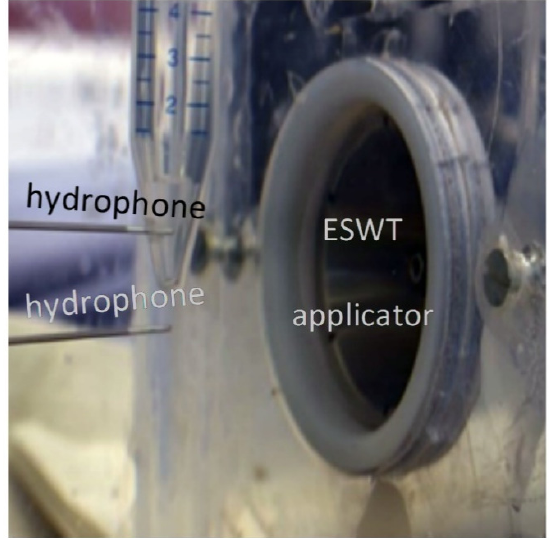
Figure 5. Representative setup of evaluating wave-pressures in the focal zone of the shockwave applicator either inside the sample ( top hydrophone) or as a free-field reference measurement ( bottom hydrophone). Depicted off-axis positions are for illustration purposes only.